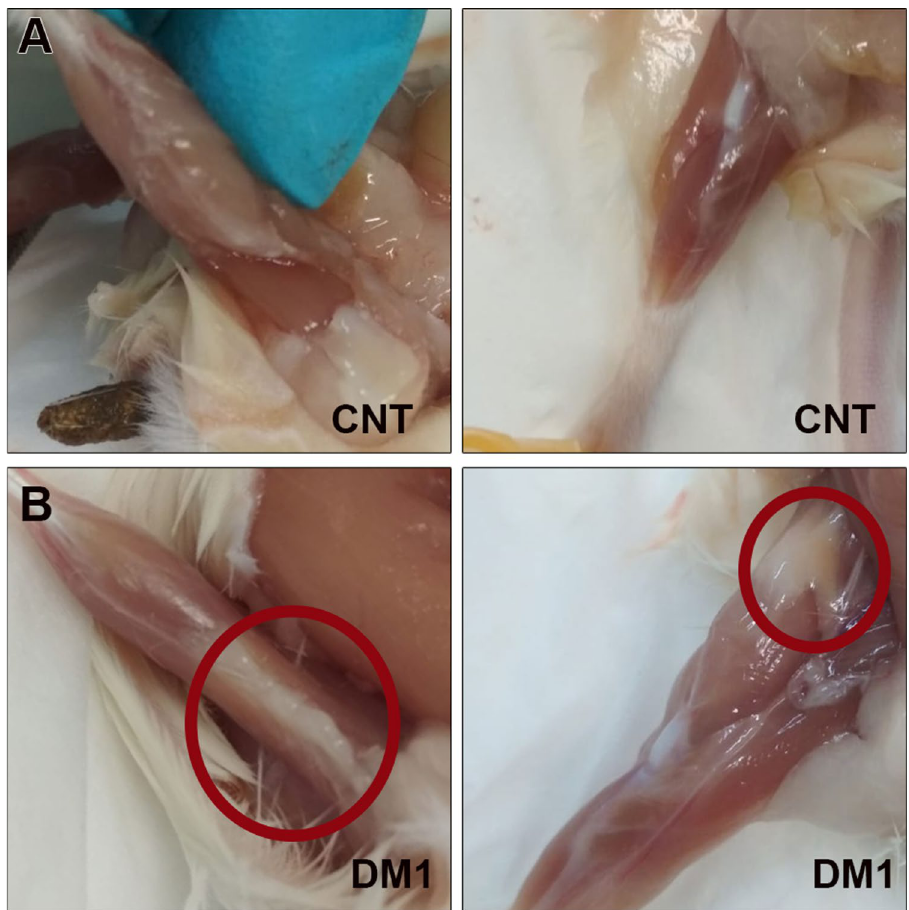
Figure 1. Skeletal muscle is replaced by fatty tissue in HSA LR mice. Representative images of dissected hind legs from control ( A ) and DM1 model mice ( B ). Red circles denote visible infiltrated fat in the gastrocnemius (left) and quadriceps (right) muscles of model